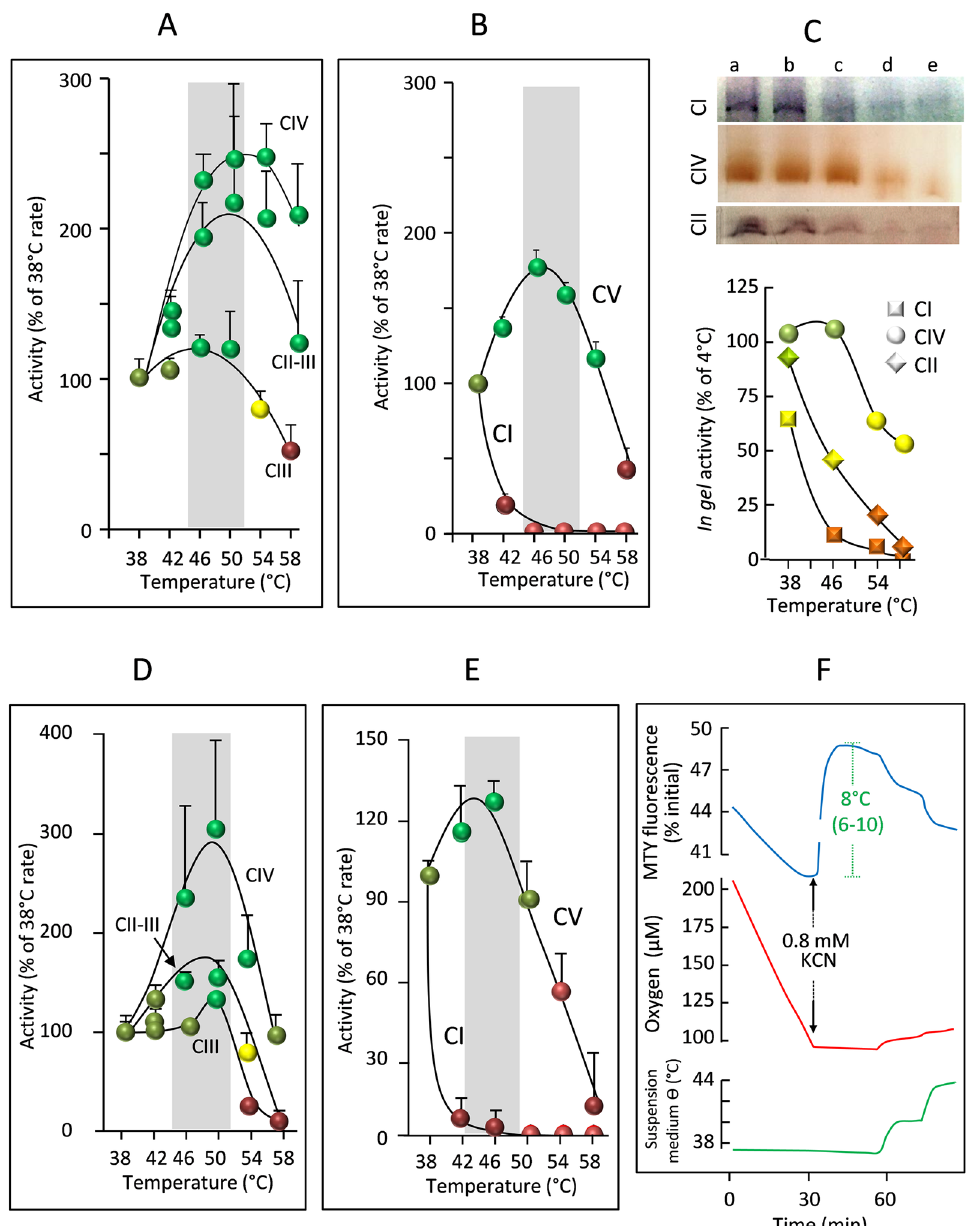
Fig 4. Effects of assay medium temperature on RC activities. (A, D) Temperature profile of cytochrome c oxidase (CIV), malonate-sensitive succinate:cytochrome c reductase (CII+CIII), and antimycin-sensitive decylubiquinol: cytochrome c reductase (CIII) activity in (A) HEK293 cells and (D) primary skin fibroblasts, after two freeze–thaw cycles, and (B, E) oligomycin-sensitive ATPase (CV) and rotenone-sensitive NADH:decylubiquinone reductase (CI) activity, after disruption of inner mitochondrial membrane in frozen (B) HEK293 cells and (E) primary skin fibroblasts by osmolysis with water [10]. Colors denote optimal (green), minimal (red), and degrees of intermediate (pale greens, yellow) activity. Grey bars indicate optimal temperature range. (C) clear native electrophoresis (CNE) in-gel activities of CI, CIV, and CII extracted from mitochondria previously incubated for 10 min in water at (a) 4 ˚C, (b) 37 ˚C, (c) 42 ˚C, (d) 46 ˚C, and (e) 55 ˚C, also plotted graphically (lower panel). (F) Changes in MTY fluorescence (blue), cell respiration (red), and temperature of cell suspension medium (green) for primary skin fibroblasts, as denoted in Fig 2A, with the addition of KCN, as shown. Graphic drawings, means, and standard deviations are from values accessible in S1 Data. HEK, human embryonic kidney; KCN, potassium cyanide; MTY, MitoThermo Yellow; RC, respiratory